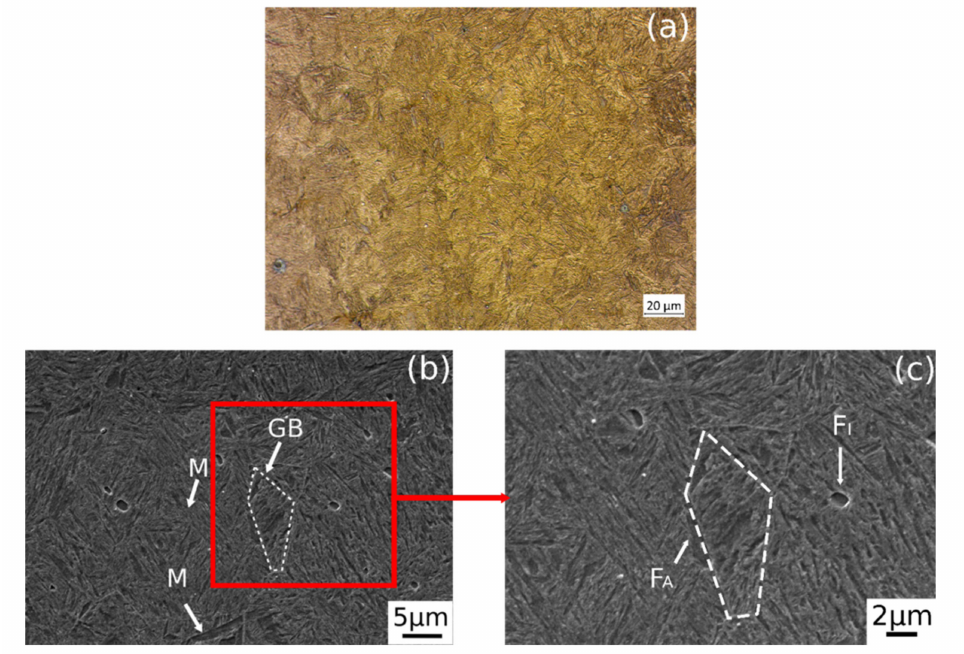
Figure 6. Optical ( a ) and SEM ( b , c ) micrographs after water quenching from 900 ◦ C (15 min holding).